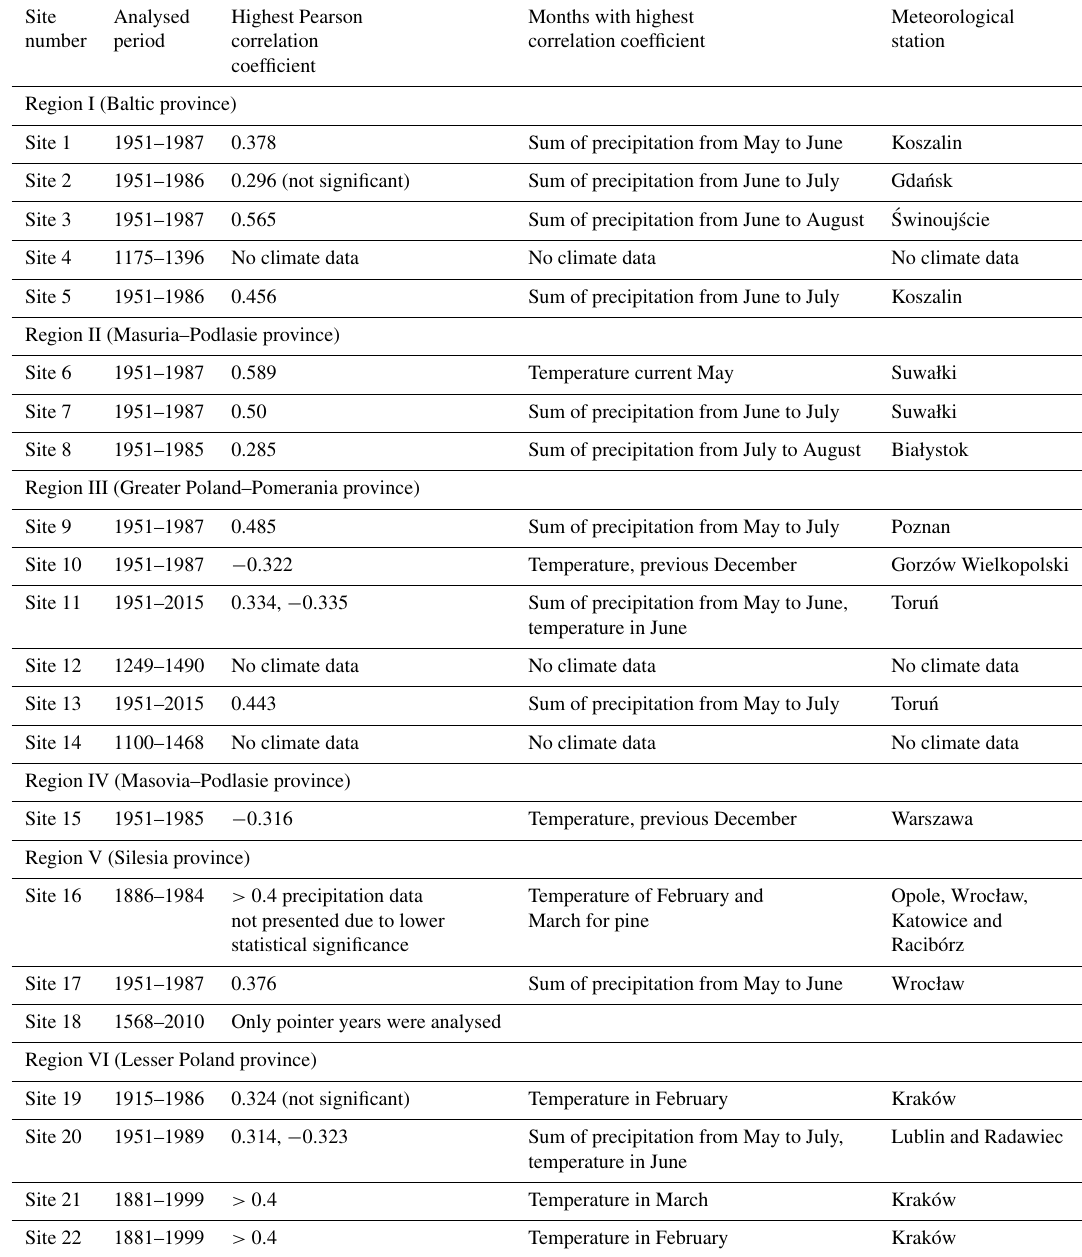
Table 6. Climate growth relationships for analysed sites. Only highest correlation coefficients are presented with a level of significance p < 0 .